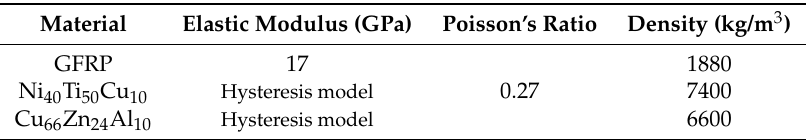
Table 6. Material properties used in the FEM